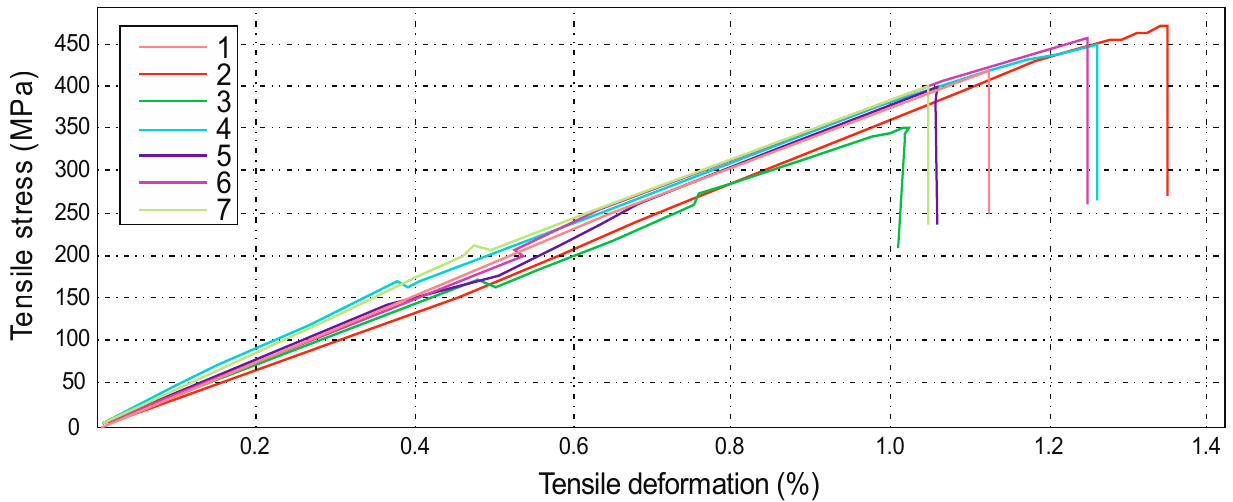
Figure 14. Graph showing the tensile stress and absolute deformation of a laminate reinforced with Dialead K63712 modular fabric, 0/90° configuration.